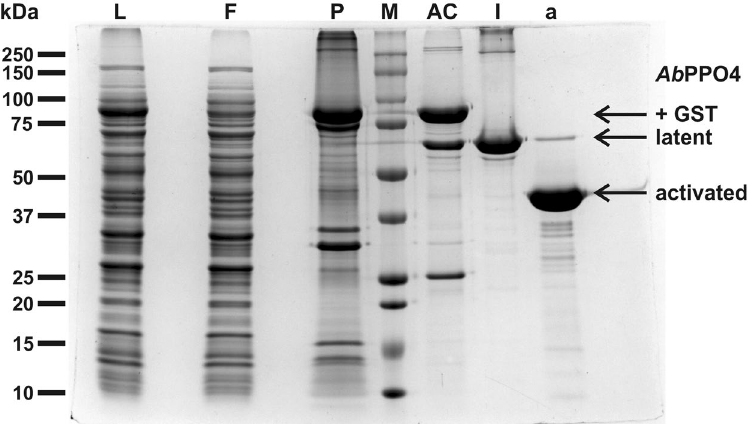
Figure 2. SDS-PAGE (10–15 % acrylamide) of the four purification stages. L : cell lysate, F : flow-through of the first affinity chromatography step, P : insoluble cell material, M : molecular weight marker; Weights of the used standard protein are indicated left of the gel., AC : eluate of the first affinity chromatography step, l : latent Ab PPO4 (eluate of the second affinity chromatography step), a : activated Ab PPO4 (eluate of size exclusion chromatography after activation with proteinase K).